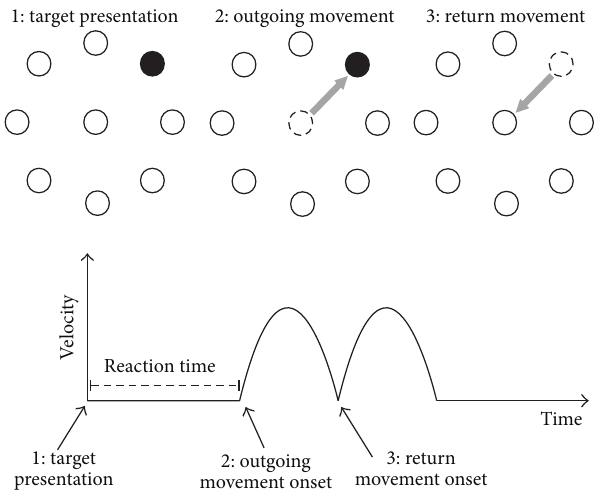
Figure 1: Motor task. (1) One of eight targets turns black (target presentation); then (2) the patient moves the cursor toward the target as soon as possible (outgoing movement) and (3) returns to the centre right after reaching the target (return movement). The reaction time is the time required to start the movement after target